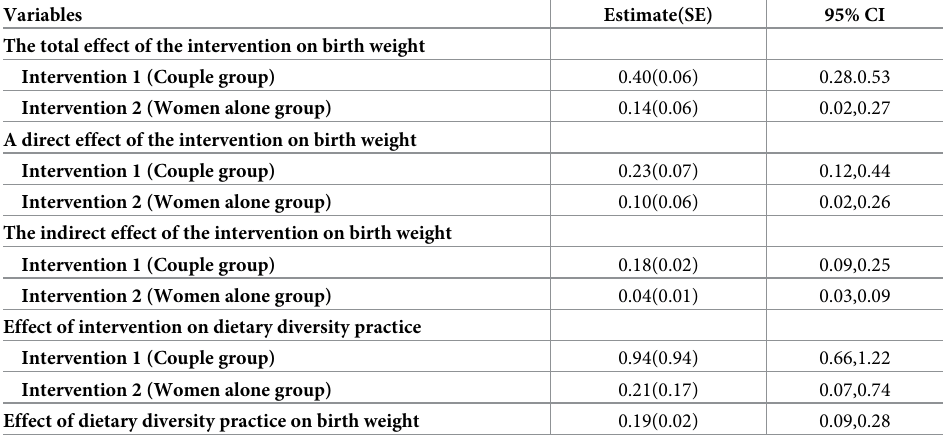
Table 6. Analysis of the direct and indirect effect of the intervention on the birth weight in Illu Aba Bor zone, Southwest Ethiopia,2019/20. Variables Estimate(SE) 95% CI The total effect of the intervention on birth weight Intervention 1 (Couple group) 0.40(0.06) 0.28.0.53 Intervention 2 (Women alone group) 0.14(0.06) 0.02,0.27 A direct effect of the intervention on birth weight Intervention 1 (Couple group) 0.23(0.07) 0.12,0.44 Intervention 2 (Women alone group) 0.10(0.06) 0.02,0.26 The indirect effect of the intervention on birth weight Intervention 1 (Couple group) 0.18(0.02) 0.09,0.25 Intervention 2 (Women alone group) 0.04(0.01) 0.03,0.09 Effect of intervention on dietary diversity practice Intervention 1 (Couple group) 0.94(0.94) 0.66,1.22 Intervention 2 (Women alone group) 0.21(0.17) 0.07,0.74 Effect of dietary diversity practice on birth weight 0.19(0.02) 0.09,0.28 The model was adjusted for maternal education, maternal age, maternal occupation, wealth status, family size, infant sex, baseline MUAC, and